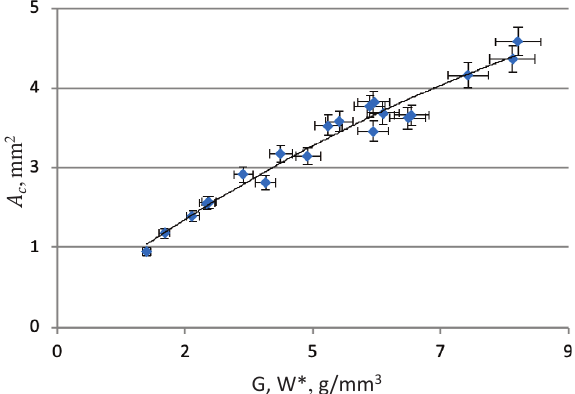
Fig. 5. Parameter 𝐺 with high precision (96.7%) describes the 𝐴 𝑐 results, shown with 5% error.